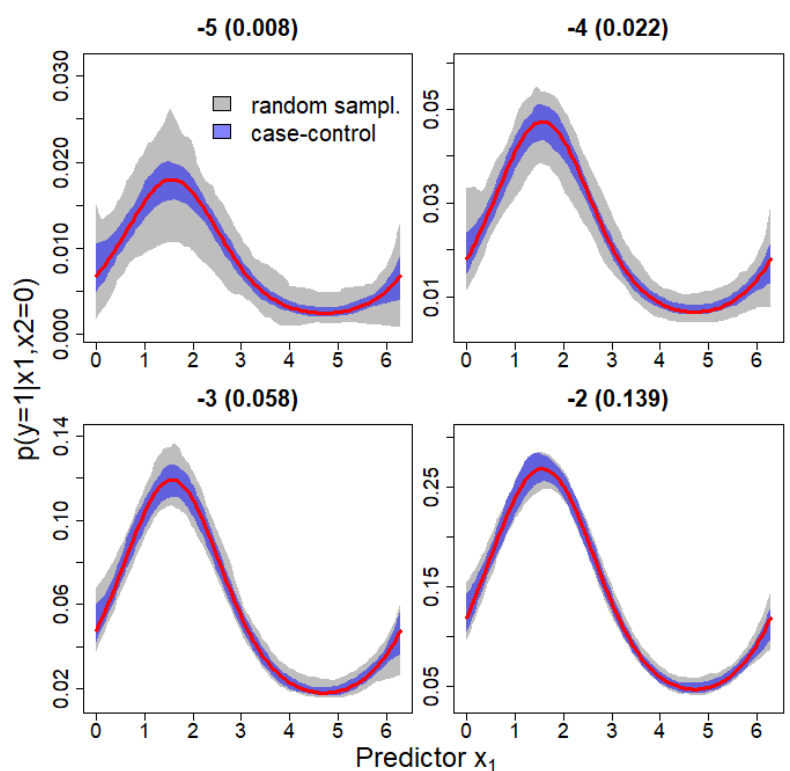
Figure 4. A case-control (CC) approach yielded unbiased and more precise inference on the nonlinear relationship between the probability of the response binary response variable y and the predictor x 1 using GAMs. Each panel displays modeling results for data simulated with a particular value of β 0 . The number on top of each panel refers to the value for β 0 while the proportion of cases prior to sampling is given between parentheses. For each β 0 value, grey and blue polygons represent 95% point-wise envelopes based on 100 simulated datasets generated through a random sampling (RS) approach or a CC approach, respectively. The true relationship between p ( y = 1 (cid:12) x 1 , x 2 = 0 ) and x 1 is depicted by the thick red line.